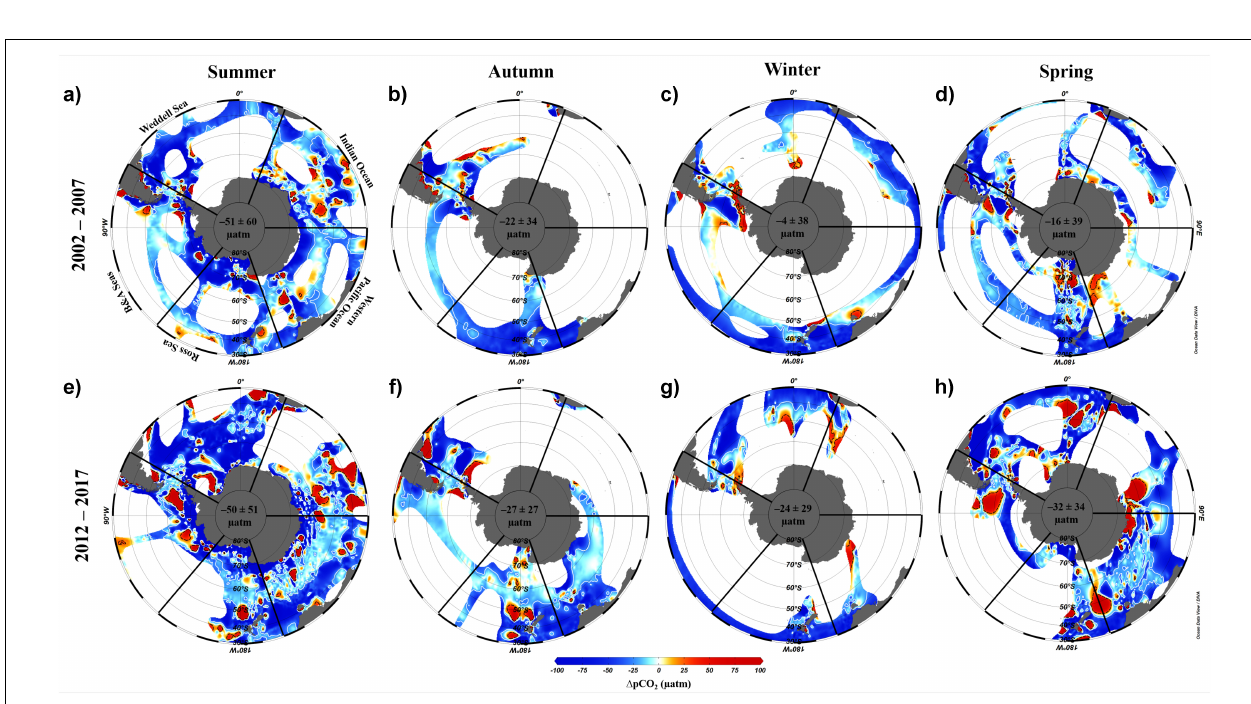
FIGURE 5 | Difference between the p CO 2 of the ocean and atmosphere ( (cid:49) p CO 2 , µ atm) by season for two composited periods: (a–d) 2002–2007 and (e–h) 2012–2017. The maps were produced using Data-Interpolating Variational Analysis (DIVA; 10 × 10 per mille) in the Ocean Data View software (Schlitzer, 2018). Seasonal (cid:49) p CO 2 was computed using publicly available data from SOCAT version 2019 (Bakker et al., 2016). Atmospheric p CO 2 was determined using monthly averaged values obtained by Palmer, Halley, Syowa and South Pole meteorological stations on Antarctica (https://www.esrl.noaa.gov/gmd/dv/site/?stacode= none). The white and black isolines depict the (cid:49) p CO 2 values of –25 and +25 µ atm, respectively. The mean and standard deviation of (cid:49) p CO 2 for the entire area for each season is shown in the centre of each map. The Southern Ocean sectors are named as: Weddell Sea, Indian Ocean, Western Pacific Ocean, Ross Sea, and Bellingshausen and Amundsen Seas. The seasonal periods computed were austral summer (JFM), autumn (AMJ), winter (JAS), and spring (OND).